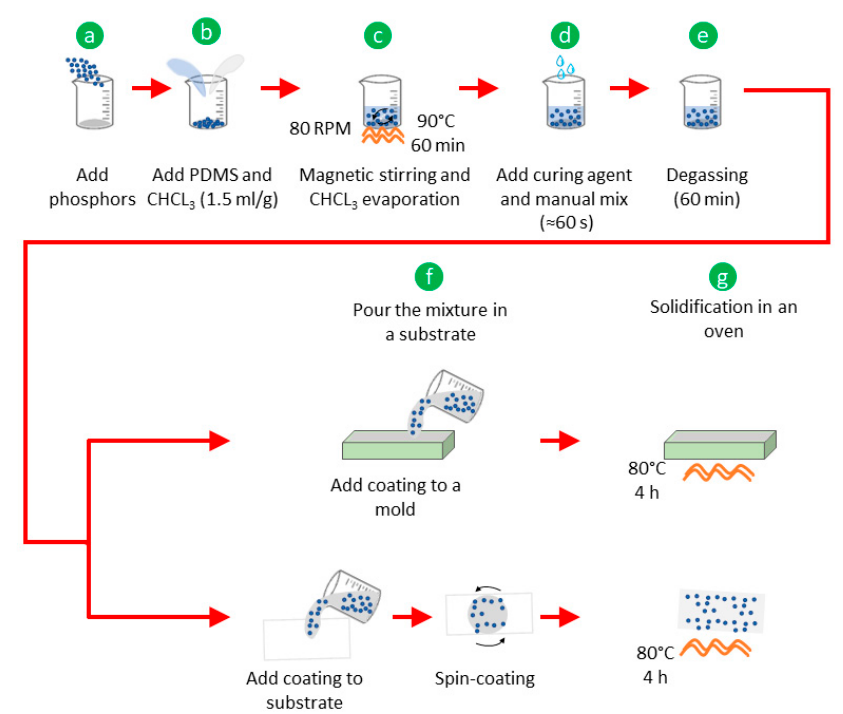
Figure 1. Mixing methodology to obtain the fluorescent polymer composites (PDMS-phosphor; see text for further details). text for further